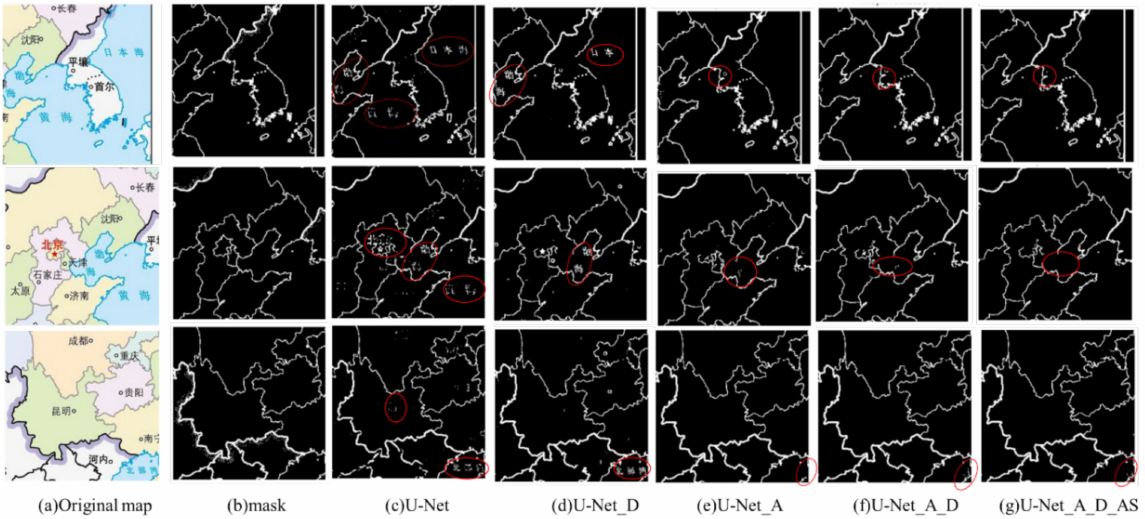
Figure 8. The extraction results of line features: ( a ) cropped color map image blocks, ( b ) labels of map line features, ( c ) the U-Net result, ( d ) the U_Net_D result, ( e ) the U_Net_A result, ( f ) the U_Net_A_D result, and ( g ) the U_Net_A_D_AS